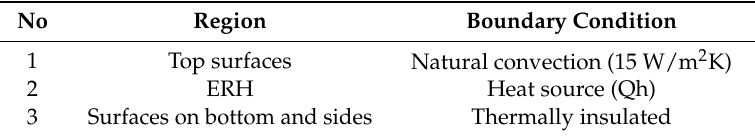
Table 6. The model thermal boundary